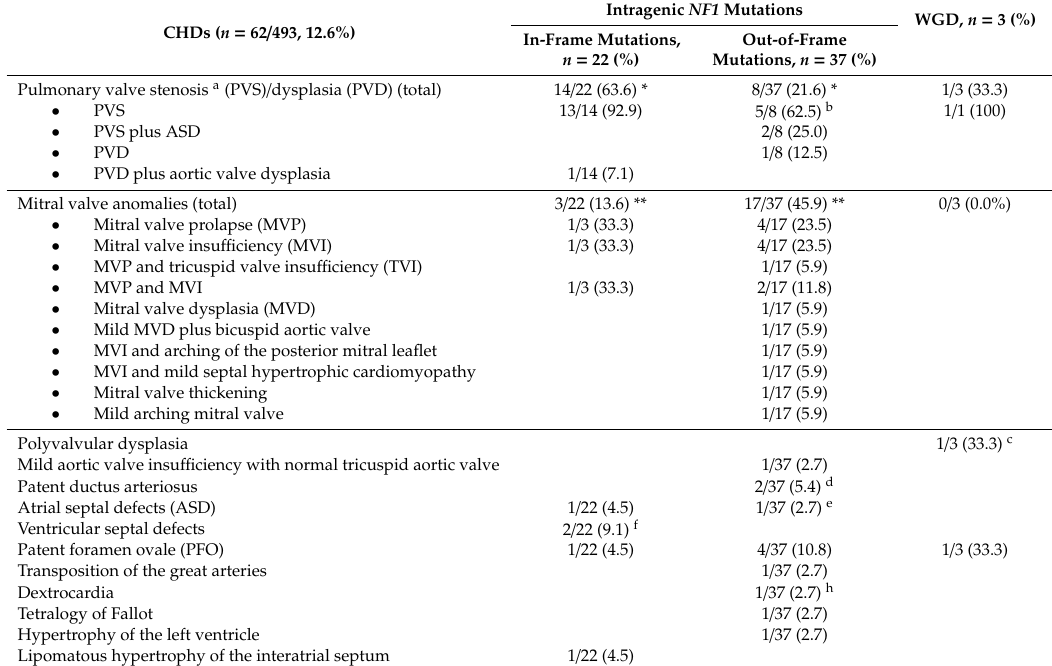
Table 3. Type and frequency of CHDs in patients with intragenic in-frame and out of frame mutations, and in NF1 patients with whole-gene deletion (WGD). CHDs ( n = 62 / 493,